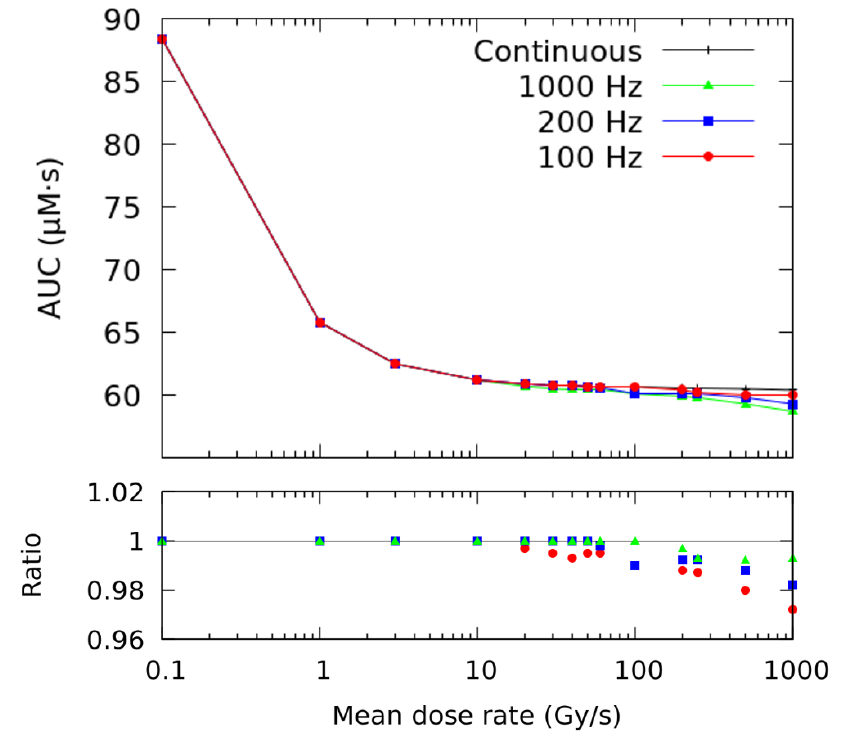
Figure 2. AUC (Area Under the Curve) of the ROO • radical as a function of the mean dose rate for continuous (black) and pulsed irradiations at different pulse repetition frequencies. The total dose was 10 Gy and the pulse width 1.8 µ s. The ratio for different pulsed beams with respect to the continuous irradiation is shown in the lower panel (note: error bars are not included in the figure; however, each data point has an uncertainty of 6%, which represents one standard